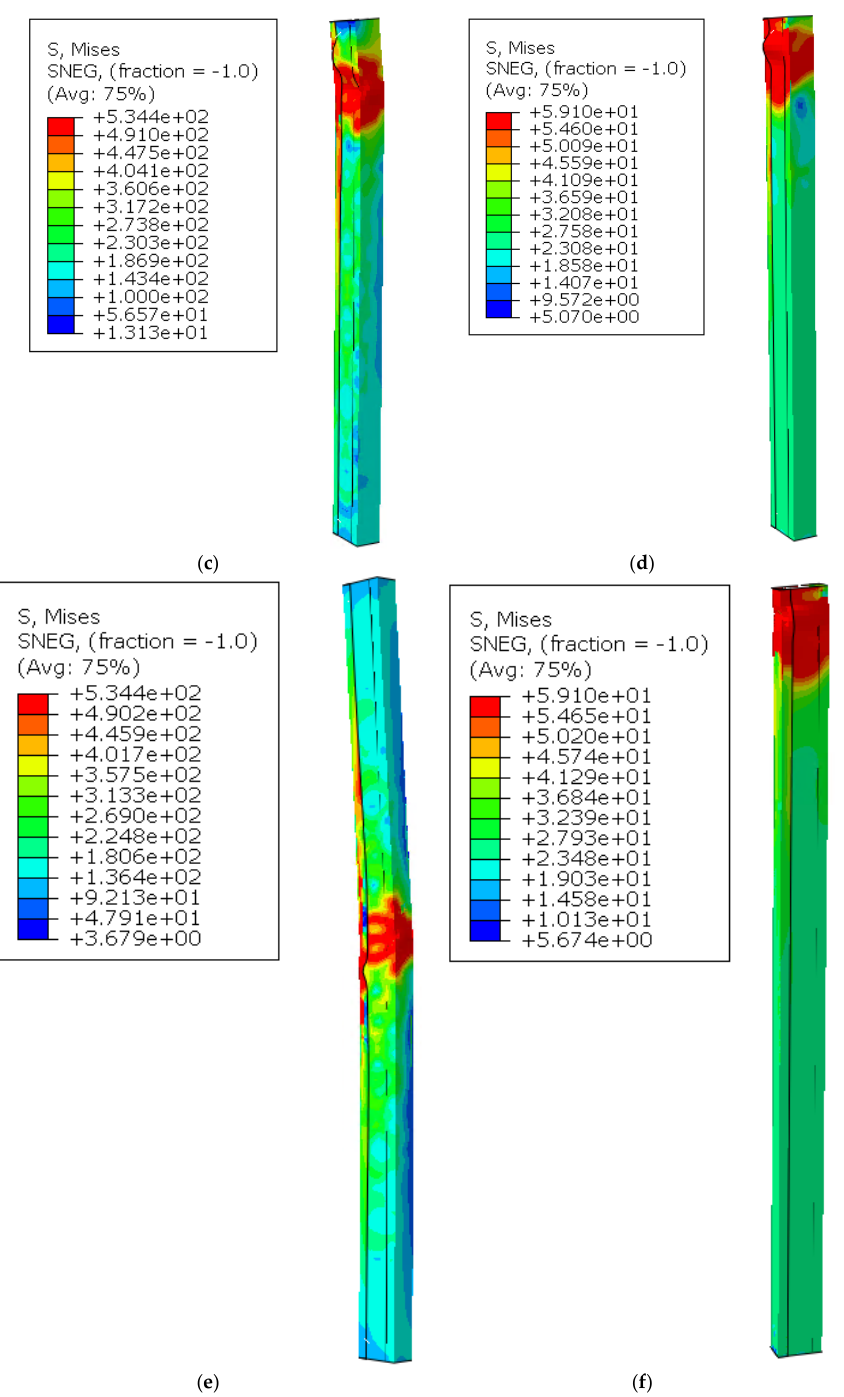
Figure 11. Buckling modes of CFS-FTF built-up columns: ( a ) BL − L300 − t1.5 − S5 − T200; ( b ) BL − L300 − t1.5 − S5 − T600; ( c ) BL − L1000 − t1.5 − S5 − T200; ( d ) BL − L1000 − t1.5 − S5 − T600; ( e ) BL − L1500 − t1.5 − S5 − T200; and ( f ) BL − L1500 − t1.5 − S5 −